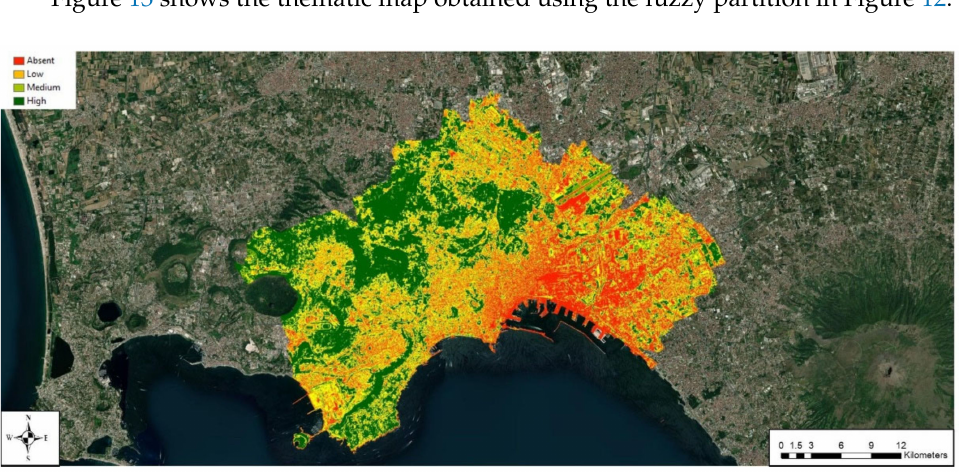
Figure 13. The thematic map of the NDVI index using the initial fuzzy partition.